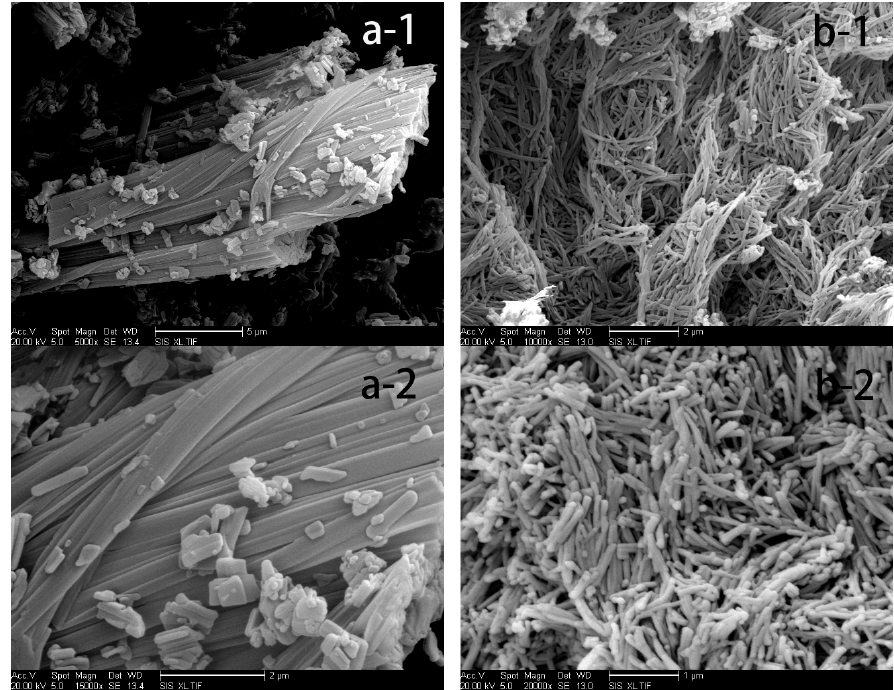
Figure 4. Scanning electron micrographs of each sample. ( a-1 ) Raw PTX (magnification of 5000); ( a-2 ) Raw PTX (magnification of 15000); ( b-1 ) PTX crystal powder (magnification of 10000) and ( b-2 ) PTX crystal powder (magnification of 20000).